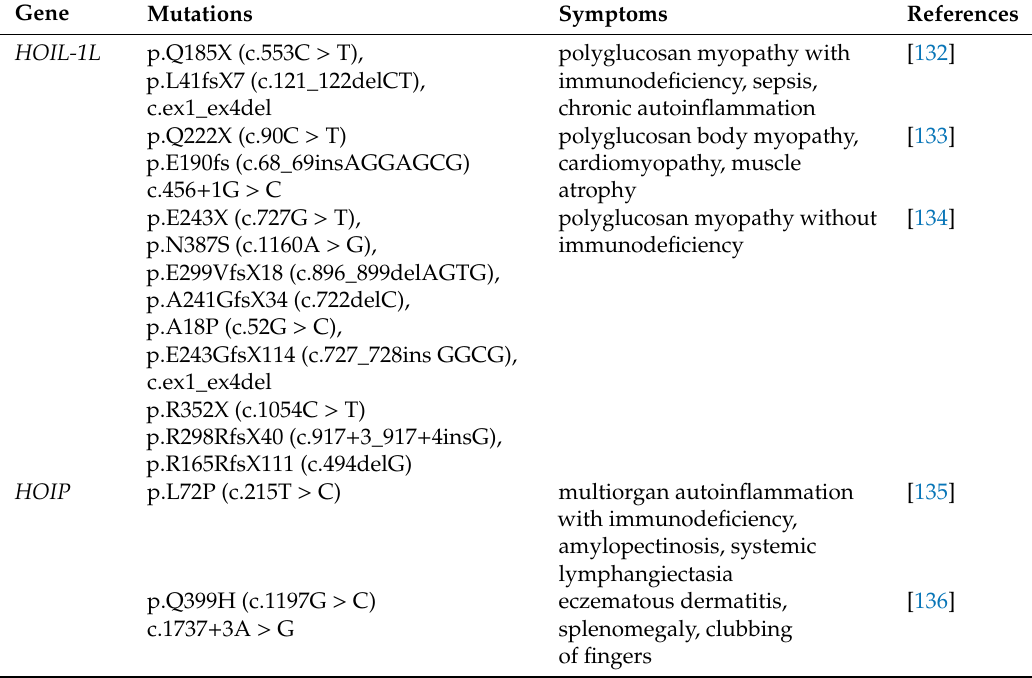
Table 1. Genetic deficiencies of human HOIL-1L and HOIP , and their